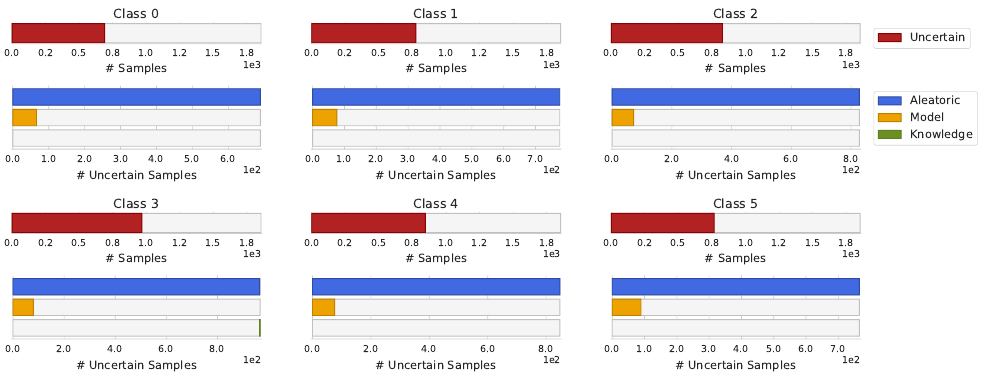
Figure 7. Uncertainty distribution by uncertainty source and